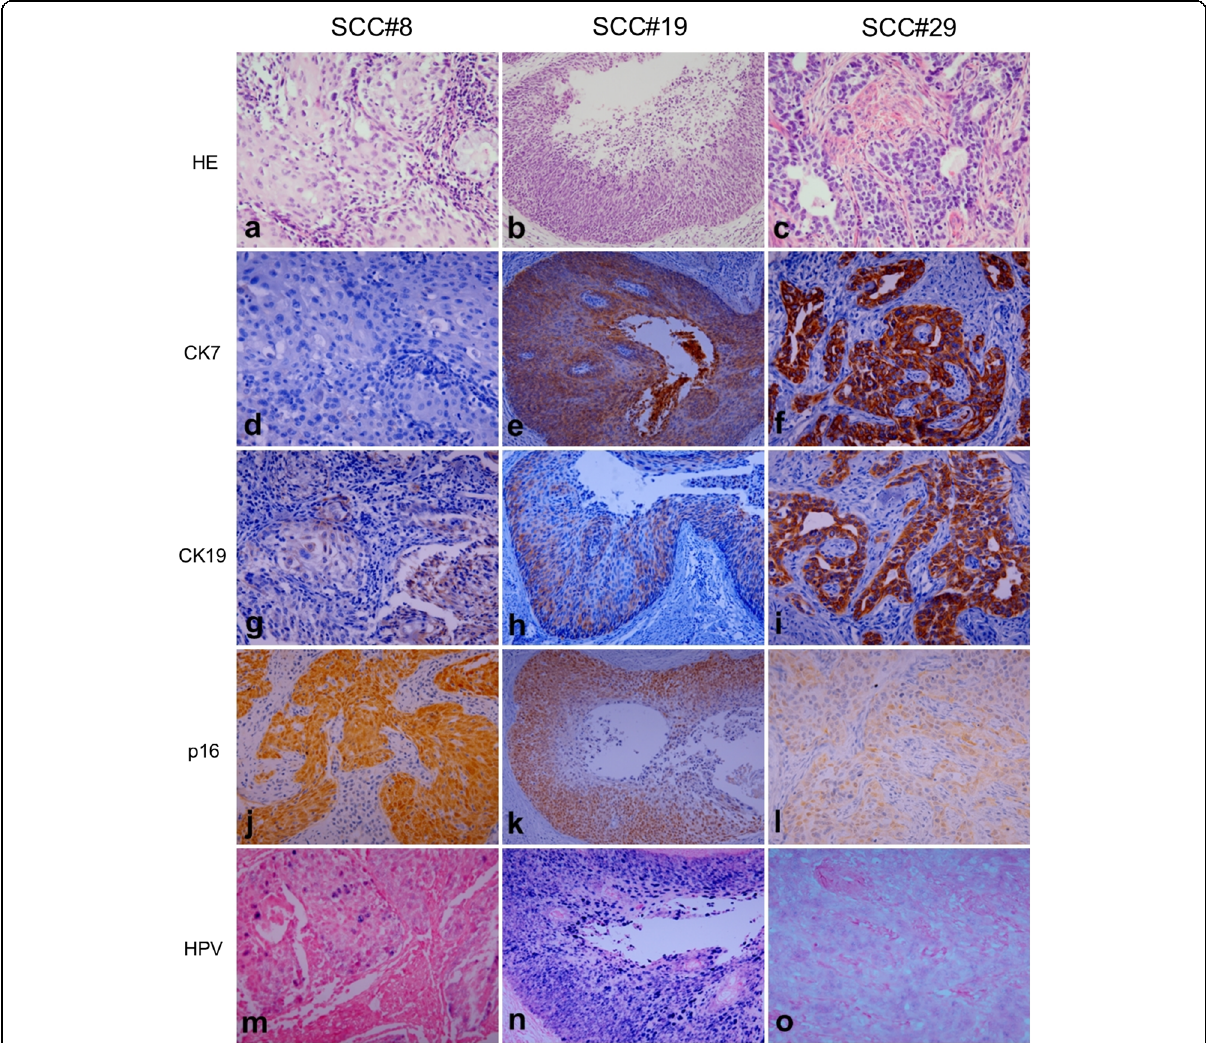
Fig. 7 Expression pattern of CK7, CK19, p16, and HR HPV in squamous cell carcinoma (SCC). HE staining shows SCC with solid tumor nests (SCC#8) ( a ), SCC with cystic change (SCC#19) ( b ), and SCC with glandular differentiation (SCC#29) ( c ). CK7 staining is negative in SCC#8 ( d ) and diffusely positive in SCC#19 ( e ) and SCC#29 ( f ). CK19 staining pattern is patchy in SCC#8 ( g ) and SCC#19 ( h ), and diffuse in SCC#29 ( i ). p16 staining is diffusely positive with variable intensity in SCC#8 ( j ), SCC#19 ( k ), and SCC#29 ( l ). HPV is present in mixture of episomal and integrated form in SCC#8 ( m ) and predominant episomal form in the cystic tumor nest and cellular debris shedding within the cystic space of SCC#19 ( n ), and integrated form in SCC#29 ( o ). Original magnifications: ( a ), ( c ), ( d ), ( f ), ( g ), ( i ), ( j ), ( l ), ( m ), and ( o ) x400; ( b ), ( e ), ( h ), ( k ) and ( n )